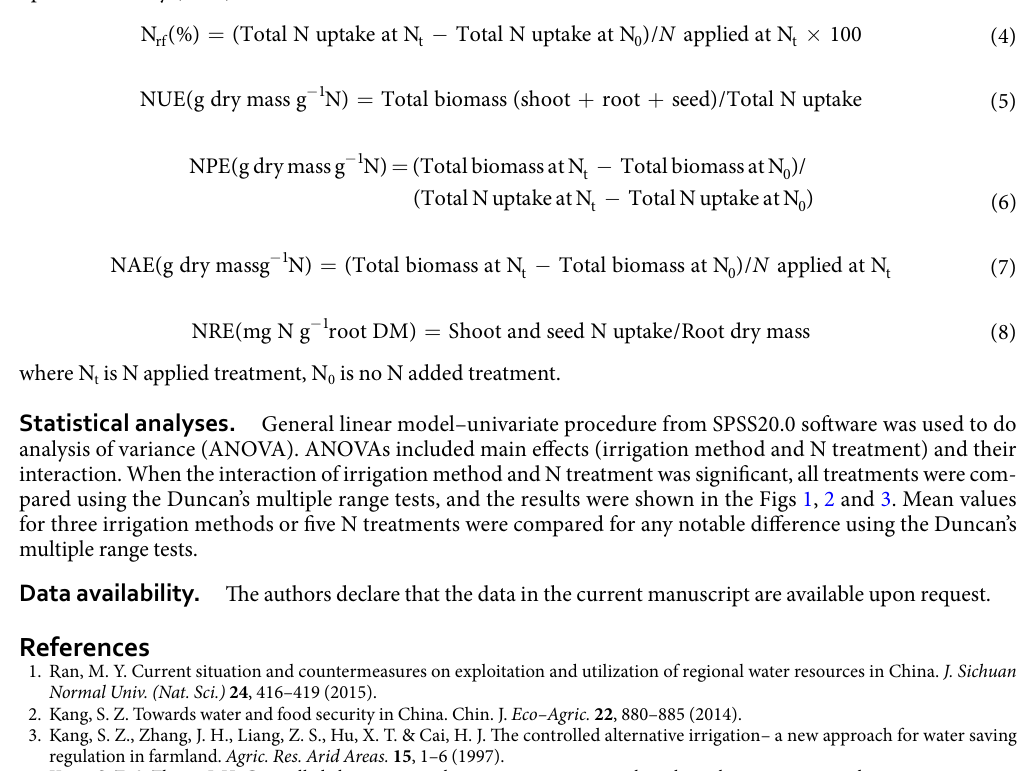
Maize N content. Maize N content (on dry mass basis) was determined from dried ground material digested with H 2 SO 4 /H 2 O 2 and analyzed by the Kjeldahl method 41 . Maize N uptake is the product of root, or shoot, or seed N content and the corresponding dry mass. Total N uptake is the sum of root, shoot and seed N uptakes 36 . Nitrogen use efficiency.